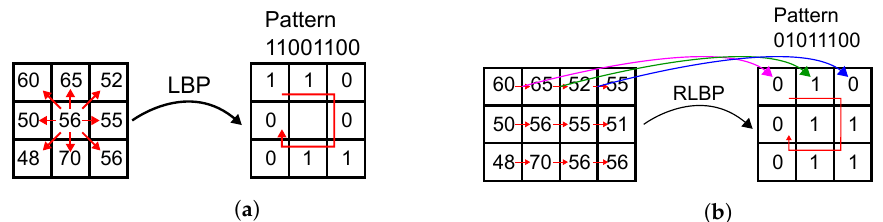
Figure 2. Examples of LBP and RLBP operators on a 3 × 3-pixel window. ( a ) LBP operator with label 11001100. ( b ) RLBP operator with label 01011100.